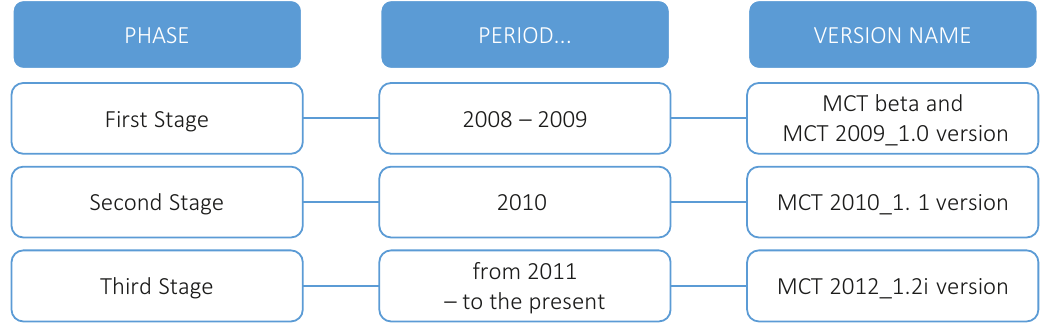
Figure 1. Evolution of CSR rankings by RKS